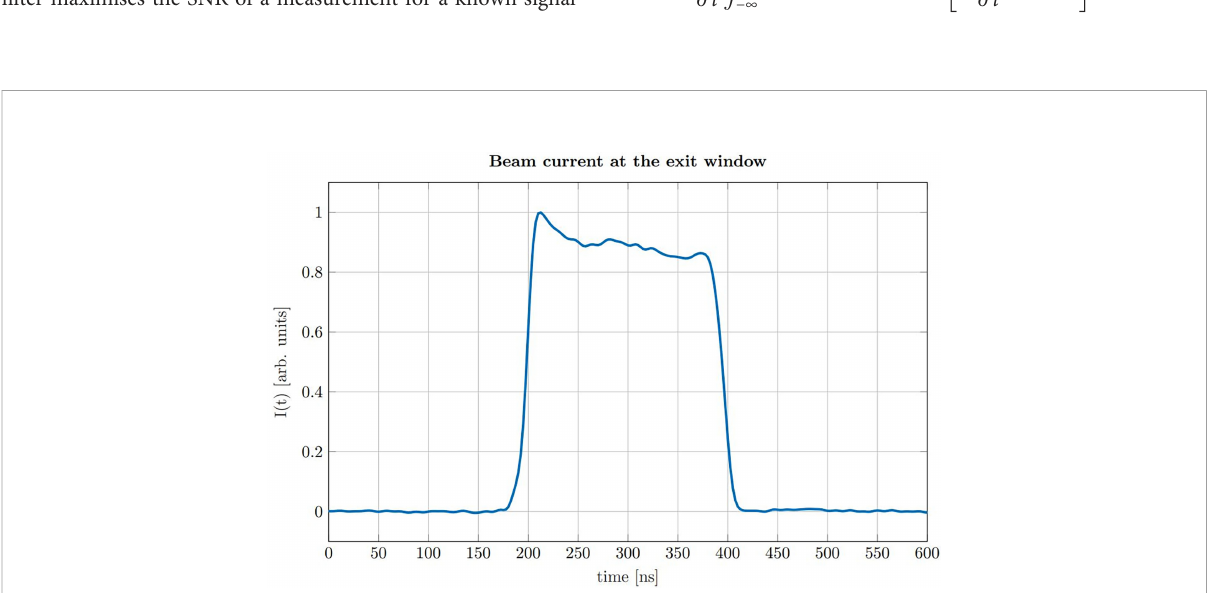
FIGURE 2 Beam current I ( t ) measured at the location of our experimental setup for a nominal pulse duration of 200